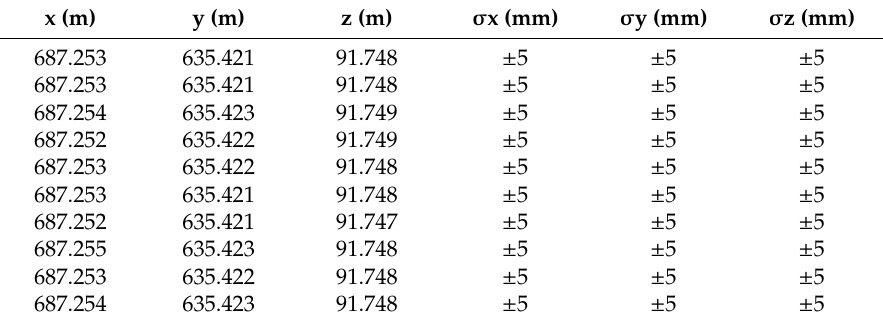
Table 3. Tested points before transferred in the bridge